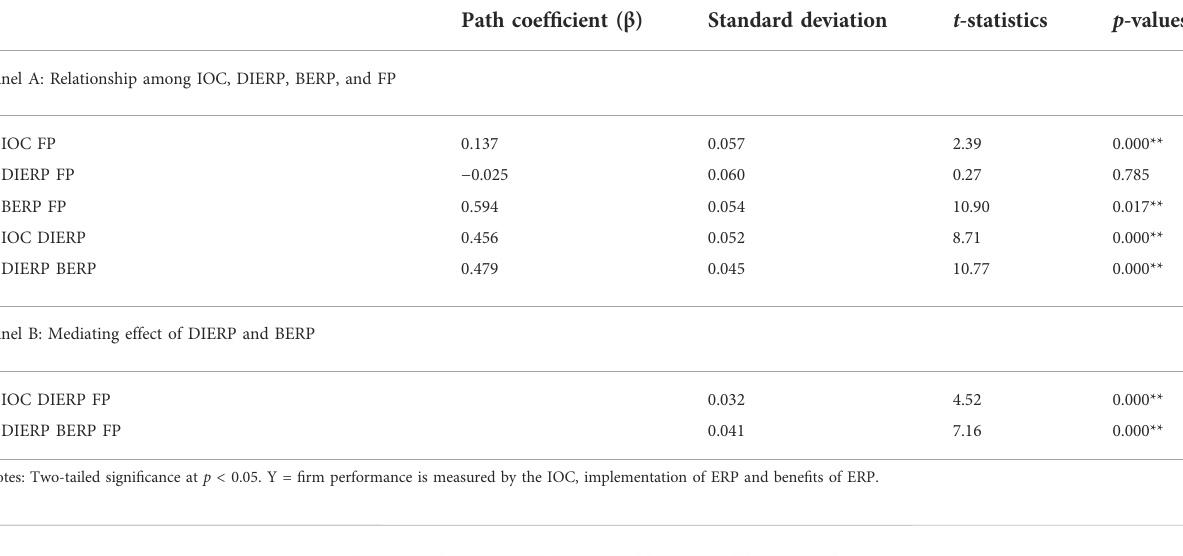
TABLE 5 Relationship among IOC, DIERP, BERP and FP, and the mediating role of BERP and DIERP.